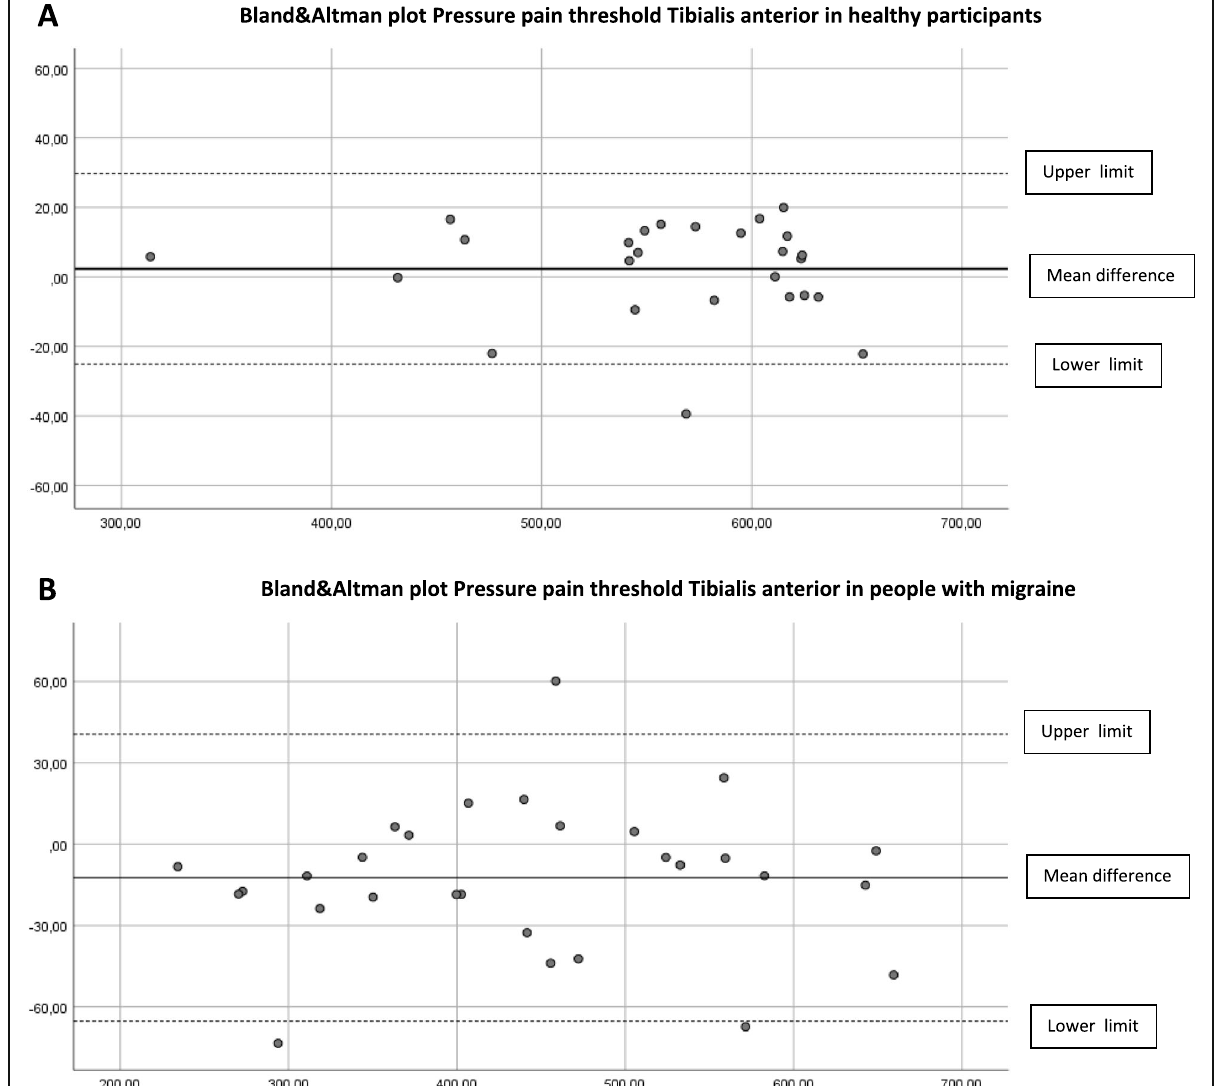
Fig. 6 A . Differences Pressure Pain Thresholds digital and analogue algometer Tibialis anterior muscle dominant side in healthy participants (mean difference, upper and lower limit) B . Differences Pressure Pain Thresholds digital and analogue algometer Tibialis anterior muscle dominant side in people with migraine (mean difference, upper and lower